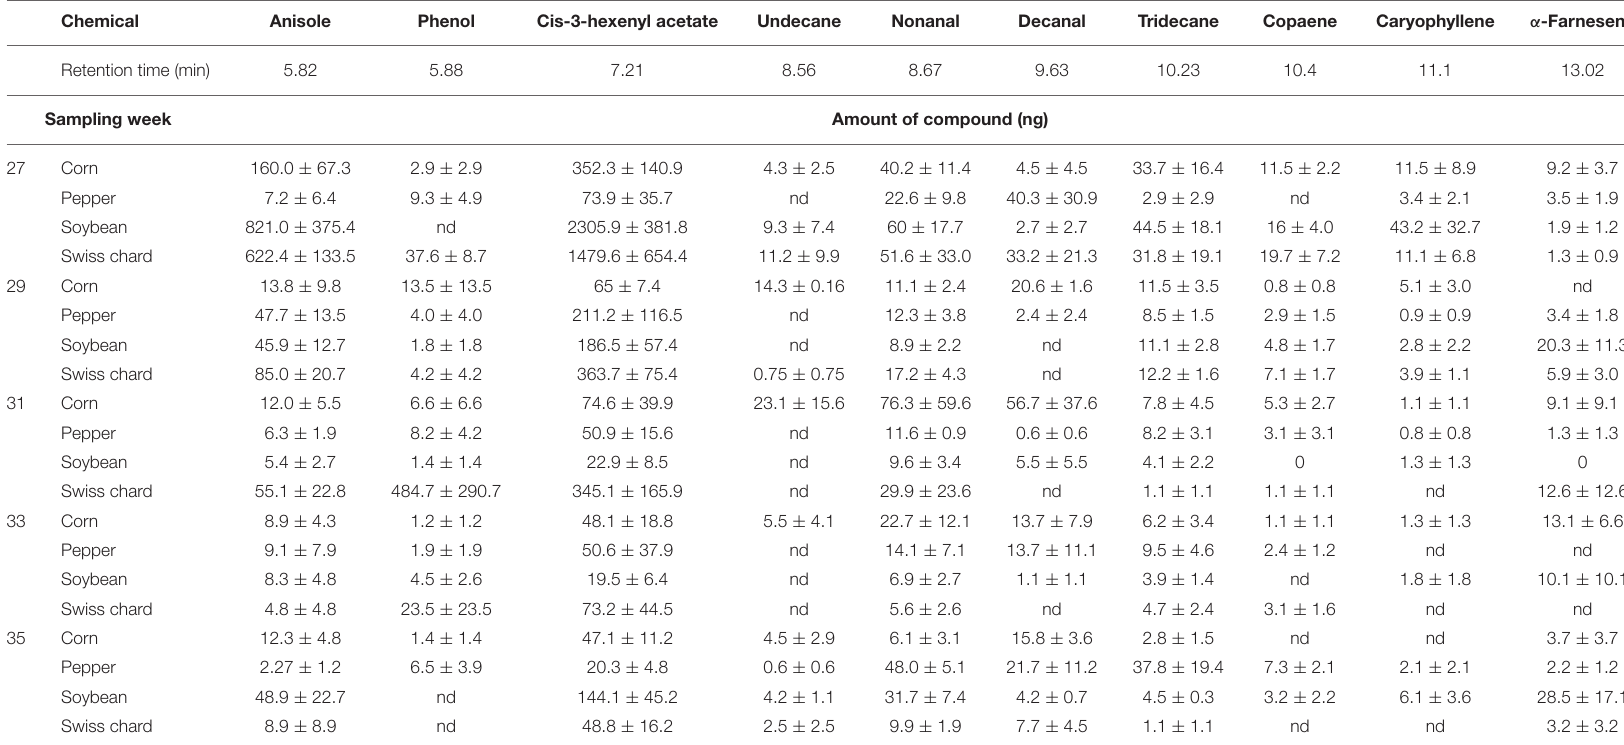
TABLE 2 | List of identified volatile organic compounds detected with GC-FID, corresponding retention times, and average relative amounts (ng) ± standard error of compound per host plant for the five sampling periods (week of year, 2014).